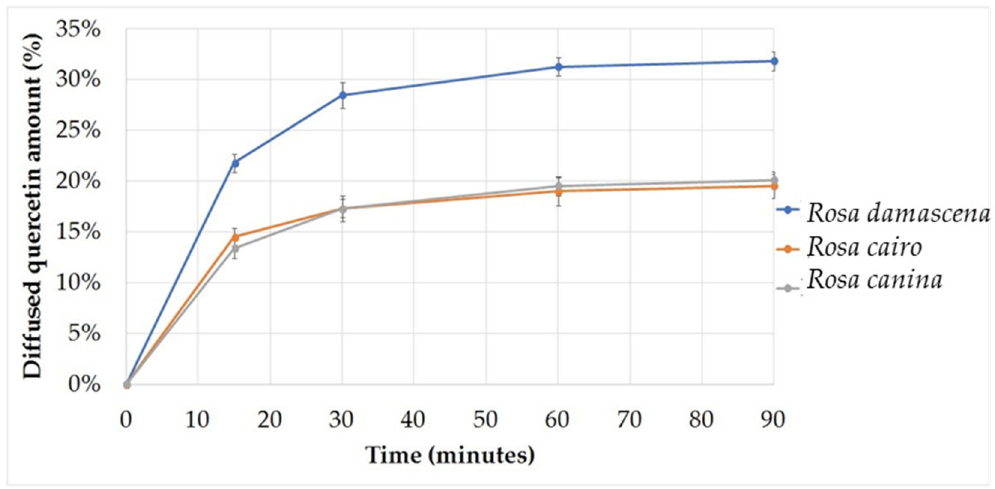
Figure 5. Diffusion profile of formulations with SNEDDS. The highest diffused amount of quercetin was obtained in the formulations with SNEDDS. The maximum diffuse amount of quercetin was 31.83% after 90 minutes. Table 3. Quercetin release rate and the diffusion coefficient values related to the compositions.